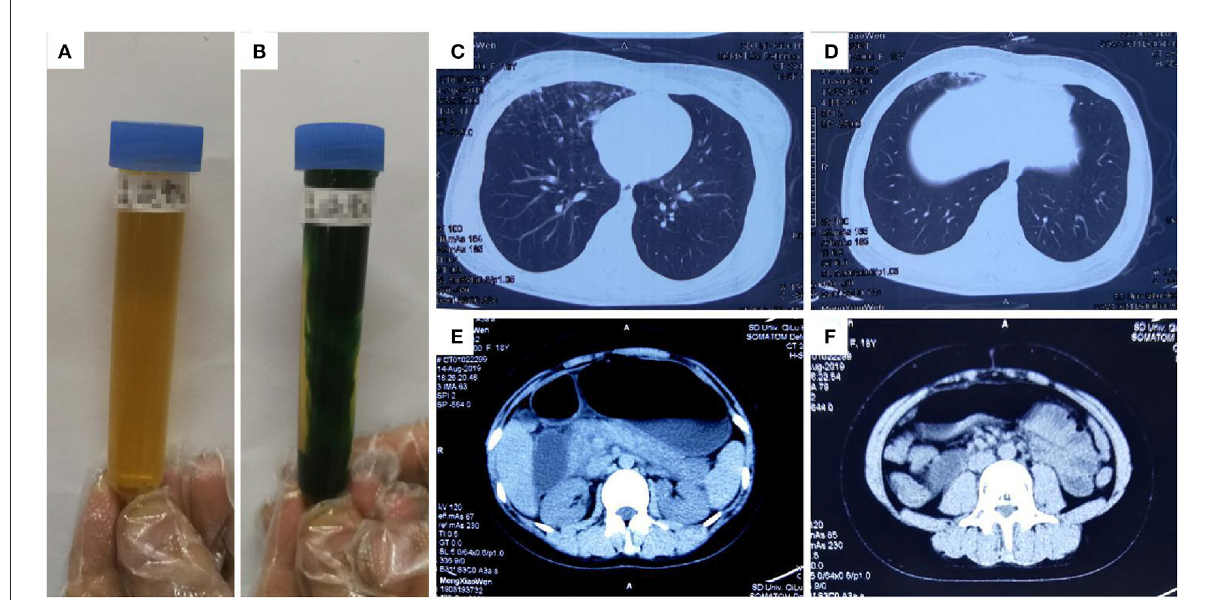
FIGURE2 Images of urine and computerized tomography (CT) for the 18-year-old woman who ingested ∼ 200mL of diquat. As shown in (A) , the patient’s original urine was dark brown in color: after exposure to sodium dithionite, the patient’s urine turned dark green (B) . The images were taken 11h after ingestion; (C,D) show lung damage, and (E,F) show gastrointestinal gas, dilatation, and fluid level; The images were taken 11h after